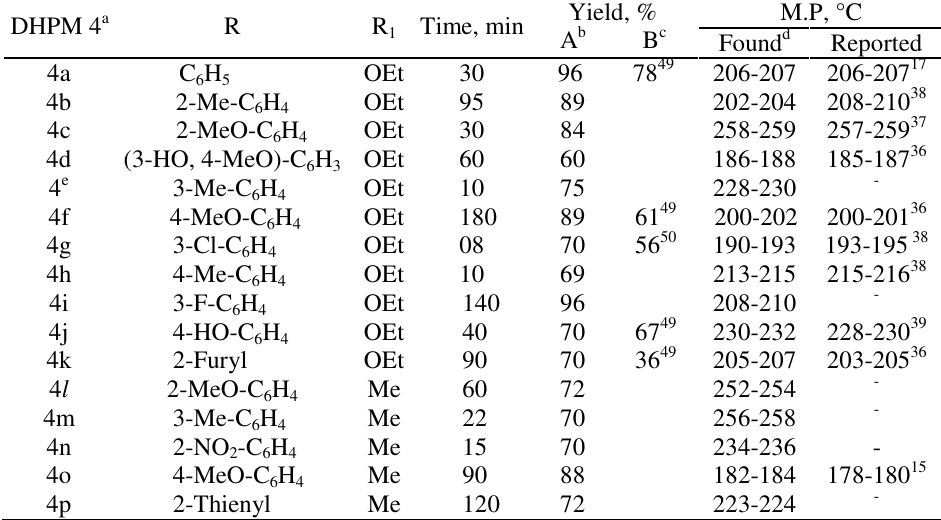
) catalysed synthesis of Biginelli 3 2